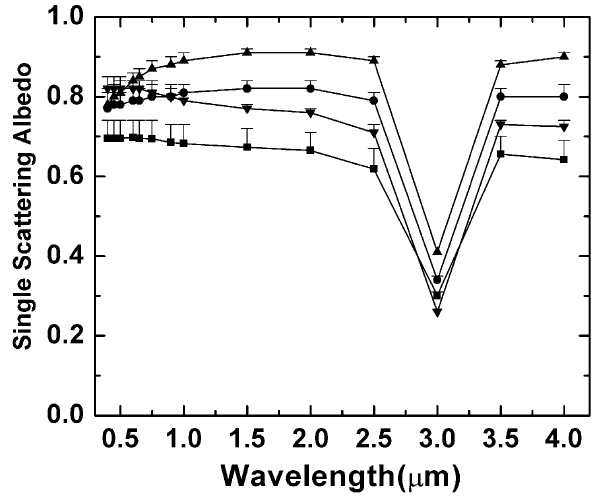
Figure 2. Spectral variation of single scattering albedo estimated for different seasons. The vertical bars shows the range of variation caused by the uncertainty in aethalometer estimated BC.